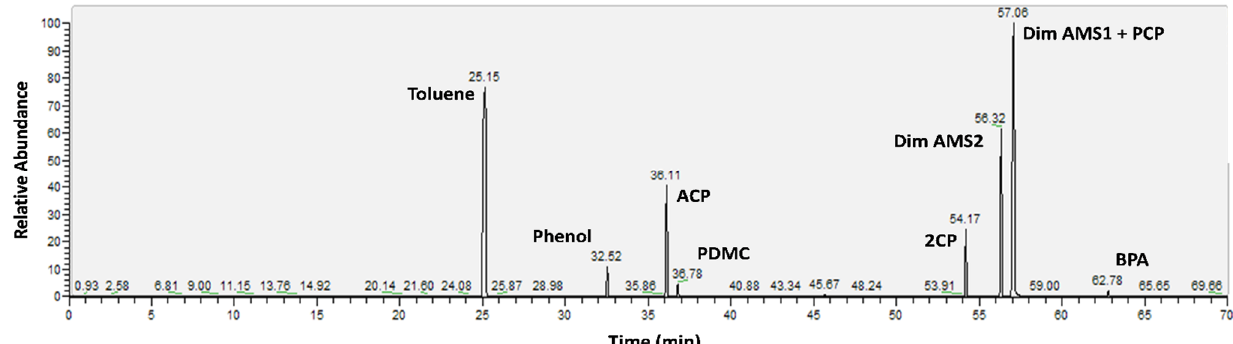
Figure 2. Representative chromatogram of chemical components present in the phenolic by-product stream (PS). The samples were diluted in toluene (20:80 w / w ) before chromatography. The details of the procedure are provided in the Materials and Methods section. ACP: acetophenone; PDMC: 2-phenyl-2-propanol; 2CP: o-cumylphenol; DimAMS1: 1,1′-(1,3,3-trimethylprop-1-ene-1,3-diyl)dibenzene; DimAMS2: 2,4,diphenyl-4-methyl-1-pentene; PCP: 4-cumylphenol and BPA: BisphenolA.